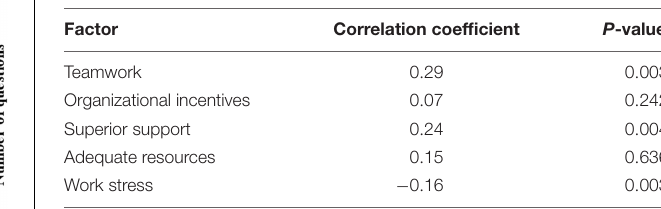
TABLE 5 | Correlation analysis of enterprise work environment and employee innovation